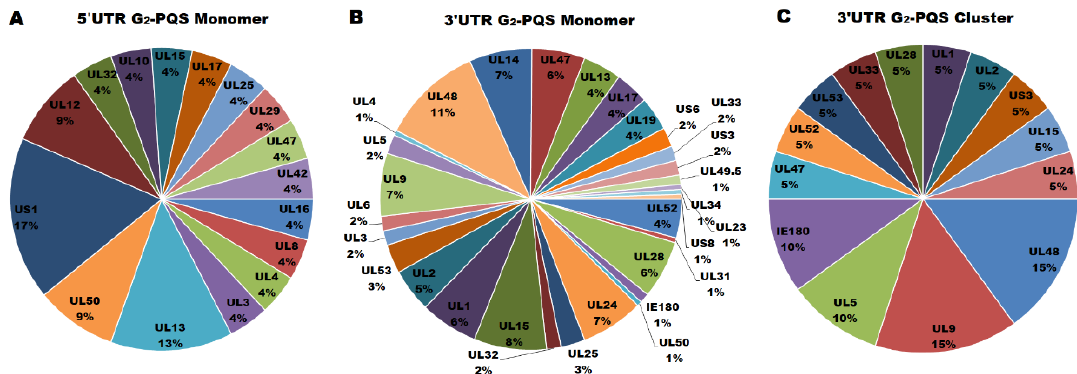
Figure 7. Quantitative distribution of G 2 -PQSs in the untranslated regions of annotated genes in PRV genome. ( A ) G 2 -PQS monomers in the 5′ U TR of the PRV genes. ( B ) G 2 -PQS monomers in the 3′ U TR of the PRV genes. ( C ) G 2 -PQS clusters in the 3′ U TR of the PRV genes.